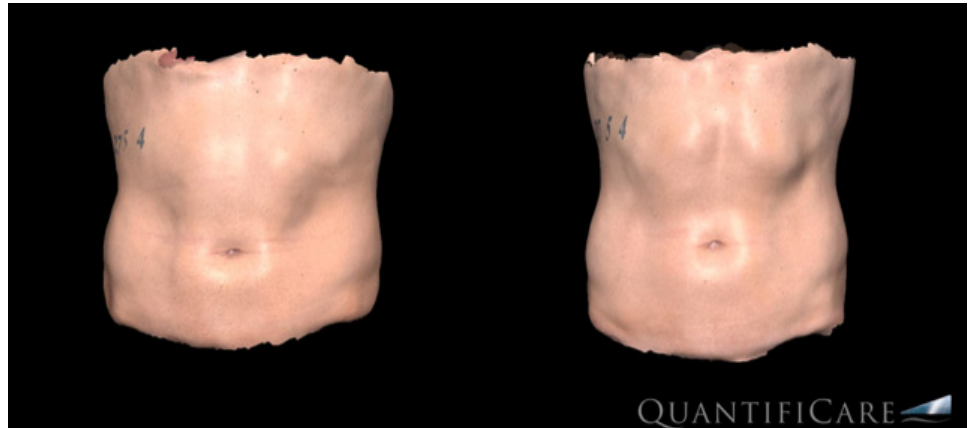
Figure 1. Three-dimensional (3D-Quantificare) optical abdominal skin surface image of a male patient before ( left ) and three months after the last treatment ( right ).